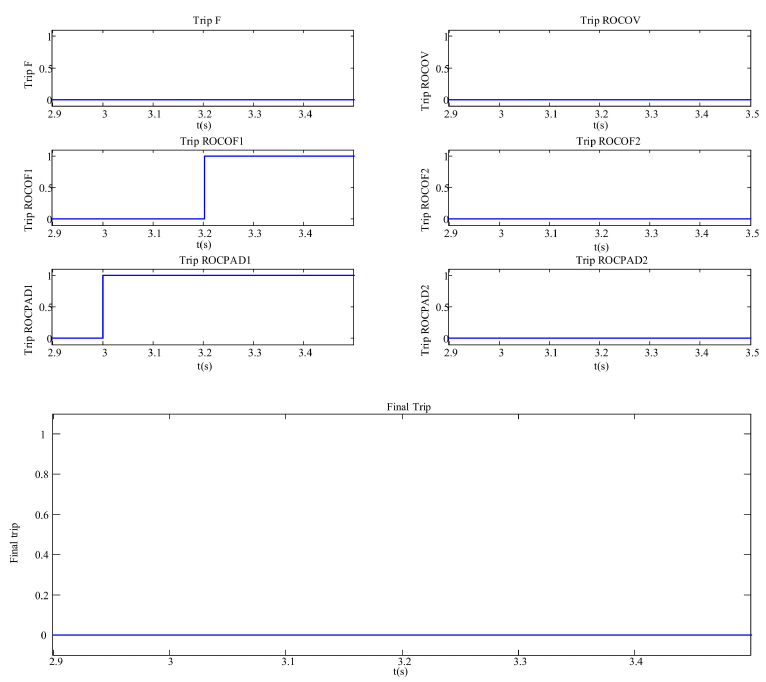
Figure 15. Trip signal of relays and the proposed algorithm in short circuit fault.